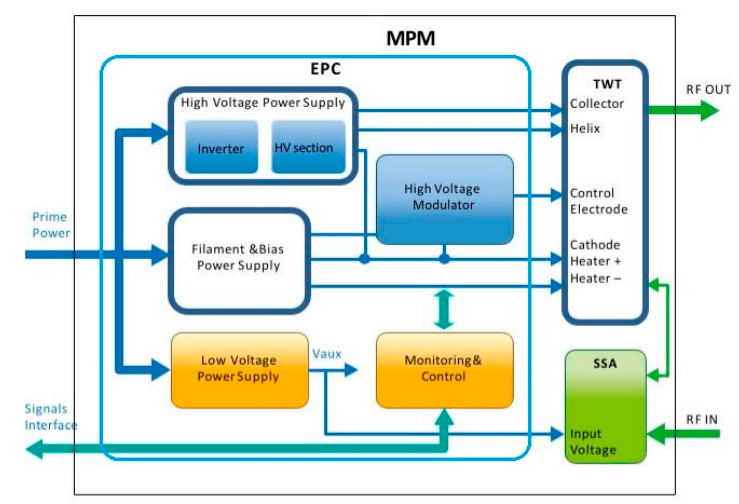
Figure 1. Schematic block diagram of a microwave power module (MPM) where EPC is the Electronic Power Conditioner, HV is the High Voltage section, RF is the Radio Frequency signal, SSA is the Solid-State Amplifier, and TWT is the Travelling-Wave Tube Amplifier.